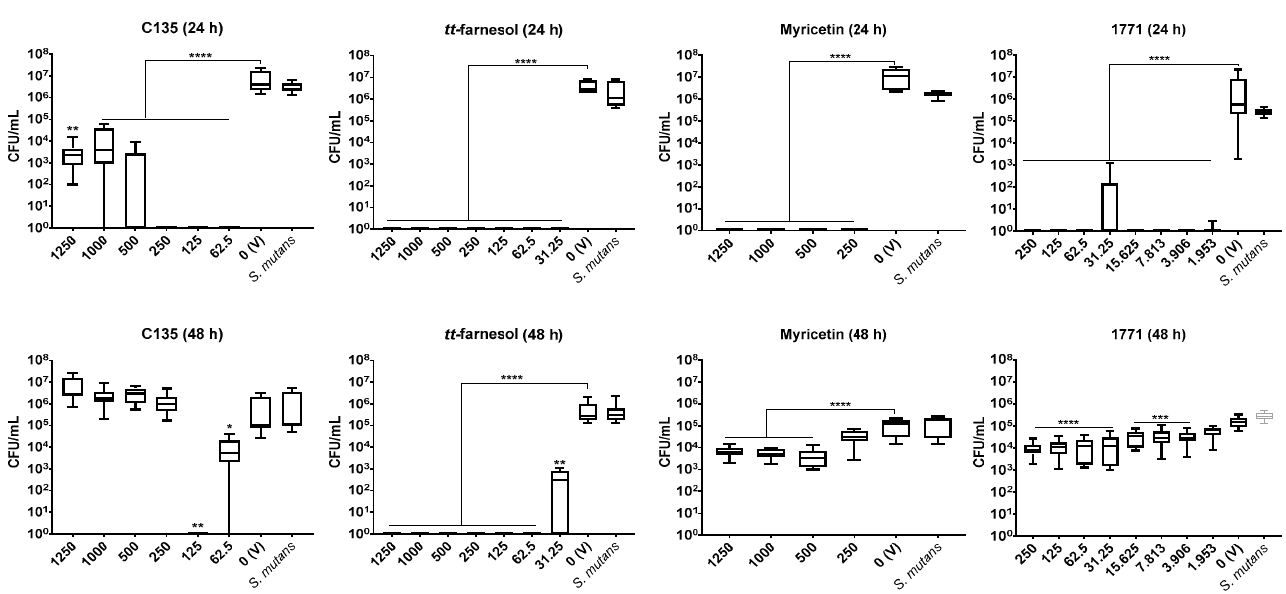
Figure 3. Antibiofilm activity of S. mutans with compounds: C135, tt -farnesol, myricetin, and 1771. On the first line are presented data of 24 h biofilm (initial biofilm formation); and right below are the data of pre-formed biofilms (48 h). The data represents median and interquartile ranges ( n = 9). Statistical differences are represented with * ( p = 0.026), ** ( p < 0.05), *** ( p < 0.001), and **** ( p < 0.0001) (Kruskal Wallis, followed by Dunn’s test). The tabulated results are in Table S3.